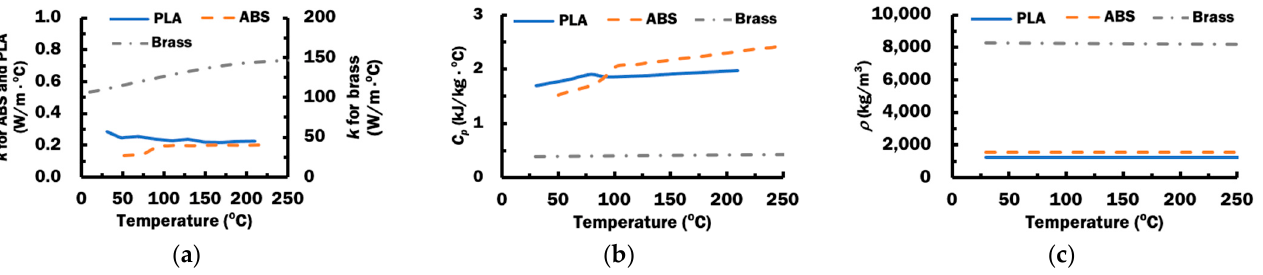
Figure 3. Temperature-dependent material properties for ABS, PLA, and brass: ( a ) thermal conductivities, k ; ( b ) specific heat capacities, C p , ( c ) densities, ρ .